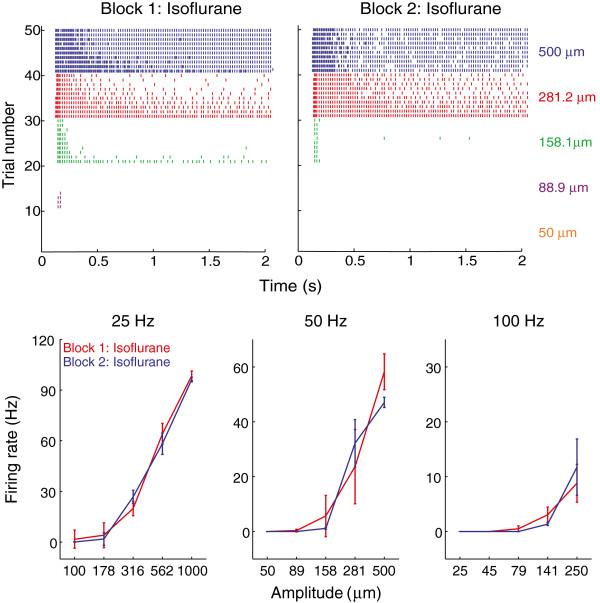
Typical responses of a single unit under anesthesia with isoflurane only. Top: Raster plots of the responses to 50-Hz stimulation in first (left) and second (right) blocks. Each row on the raster plots represents the spike train of the single unit corresponding to a given stimulus lasting for 2 seconds. Stimuli were presented ten times at each of five amplitudes (each indicated by a different color; at this frequency, the faintest stimulus did not elicit a response in this afferent). Bottom: Mean firing rates as a function of amplitude at the three frequencies tested. Each point indicates the average firing rate over 10 repetitions of each stimulus. Error bars denote the standard deviation. Note that we observed entrainment plateaus in a subset of fibers [14], but these were relatively uncommon given how sparsely amplitudes were sampled at each frequency.